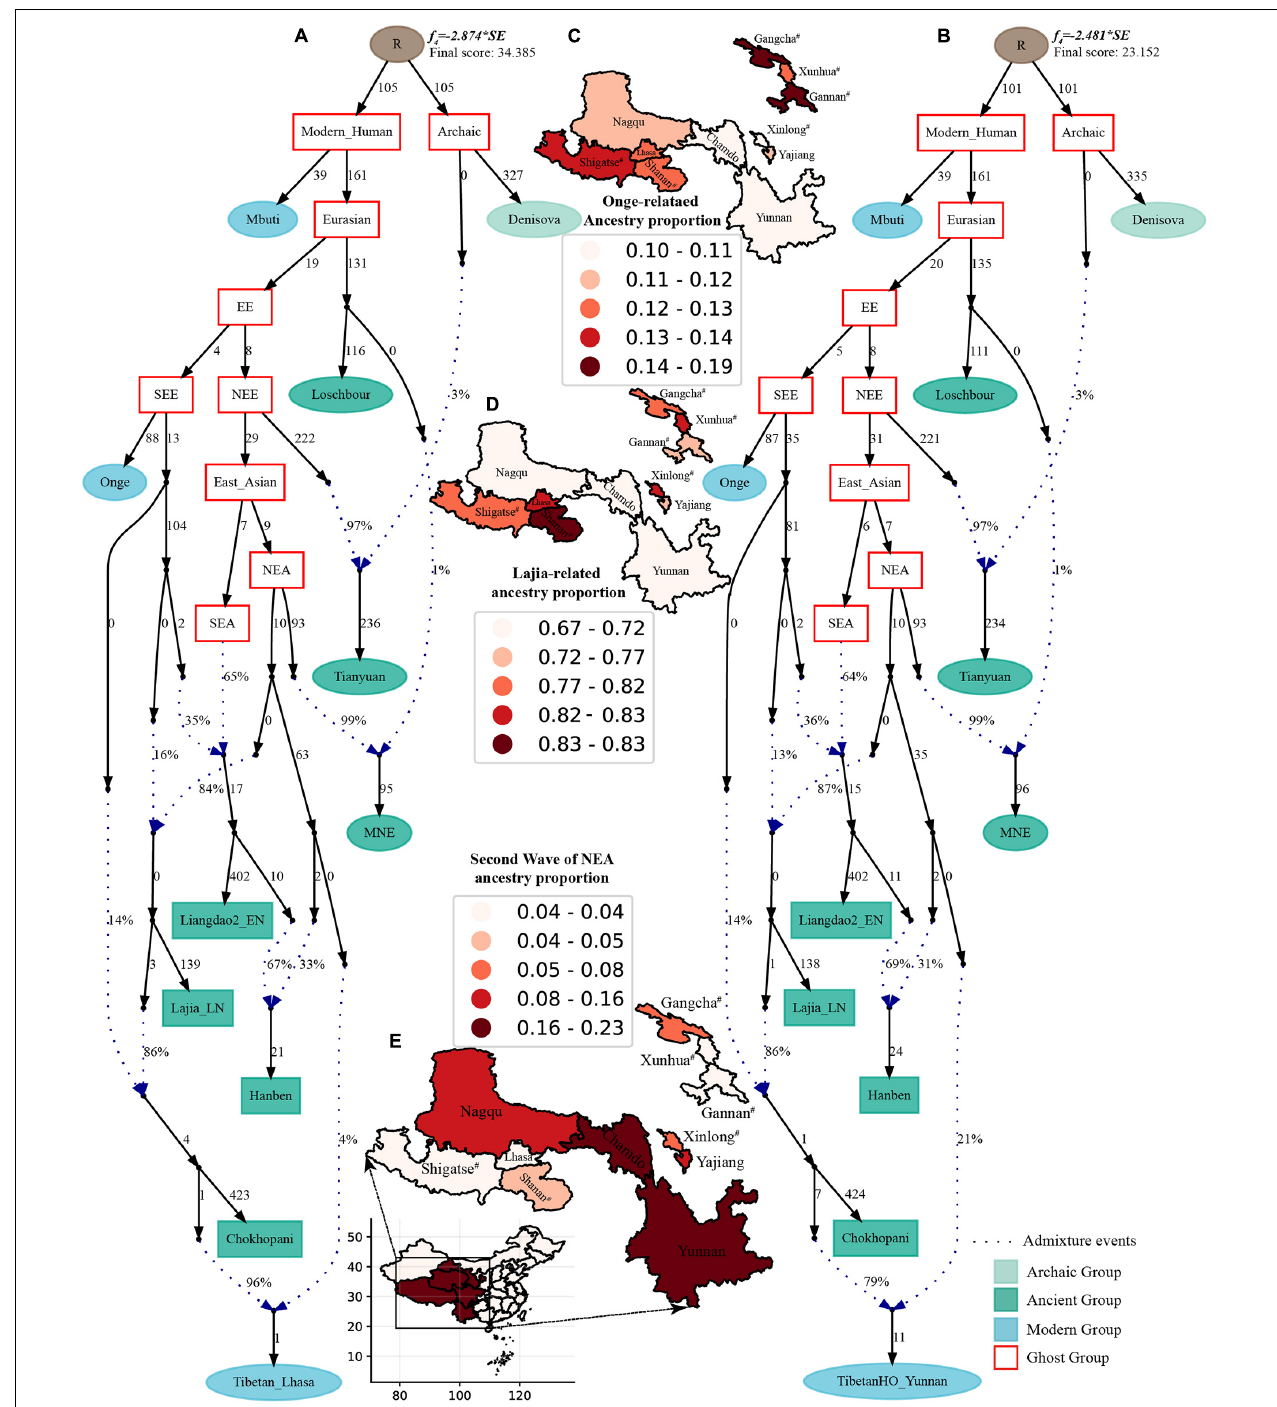
FIGURE 6 | Admixture graph model of East Asians and modern Tibetans based on the Human Origin dataset. Admixture history of highland Tibetan from Lhasa (A) and lowland Tibetan from Yunnan (B) . Heatmap showed the ancestry composition of modern Tibetans from three source populations: deep hunter-gatherer One-related ancestry (C) , the first batch of Neolithic farmer-associated ancestry (D) and the second batch of Neolithic farmer related ancestry (E) . Denisovan and Central African of Mbuti were used as the Archaic and modern roots respectively. Western Eurasian was represented by Loschbour. Deep southern Eurasian (SEE) and northern Eurasian (NEE) were represented by South Asian Hunter-Gatherers of Onge and 40,000-year-old Tianyuan people. East Asian subsequently diverged as NEA (NEA) and SEA (SEA). All f 4 -statistics of included populations are predicted to within 3 standard errors of their observed values. Branch lengths are given in units of 1000 times the f 2 drift distance (rounded to the nearest integer). Pound signs denoted the modern populations added to the basic model of A,B with larger Z-scores or Zero internal branch length. Blue dotted lines denoted admixture events with admixture proportions as shown.